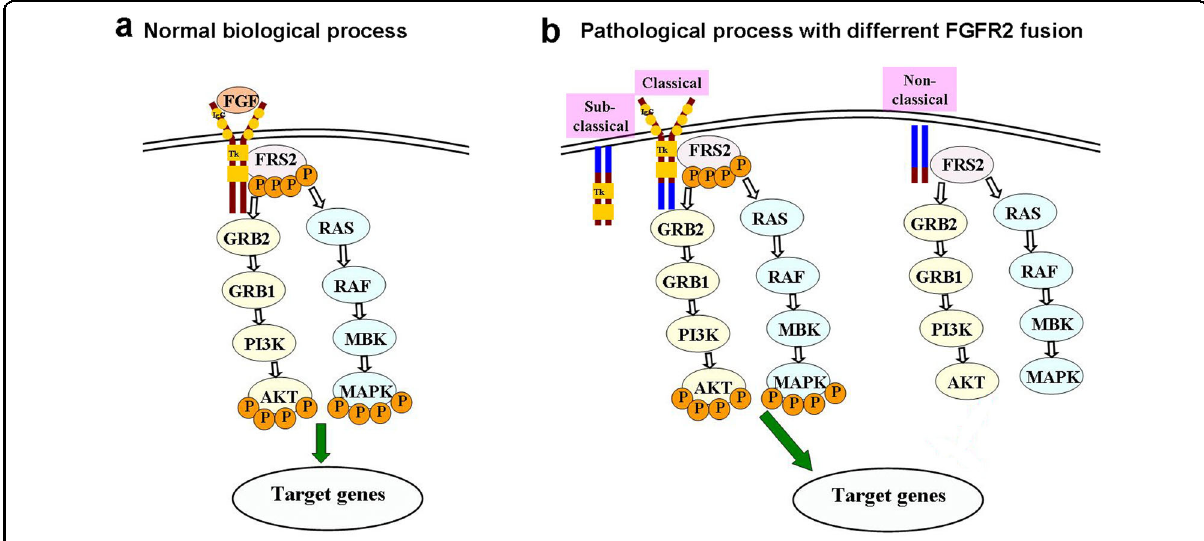
Fig. 8 Models for the signaling transduction of fusion chimeras and targeted drugs working in the downstream of FGF signal pathway. Normal biological processes of FGF signal pathway ( a ). Sub-classical and classical chimeras lead to formation of a fusion protein consisting of a transcription factor fused to an FGFR kinase domain with consequent FGFR dimerization and activation leading to ligand-independent FGF signaling. Non-classical fusion cannot active downstream signal pathway. SMKIs suppressed the phosphorylation of FRS2, AKT, and MAPK then confer anchorage-independent growth and in vivo tumorigenesis ( b ). represents Ig-like domain of FGFR2 , represents tyrosine kinase domain of FGFR2 , represents phosphorylation, and represents stimulating target gene